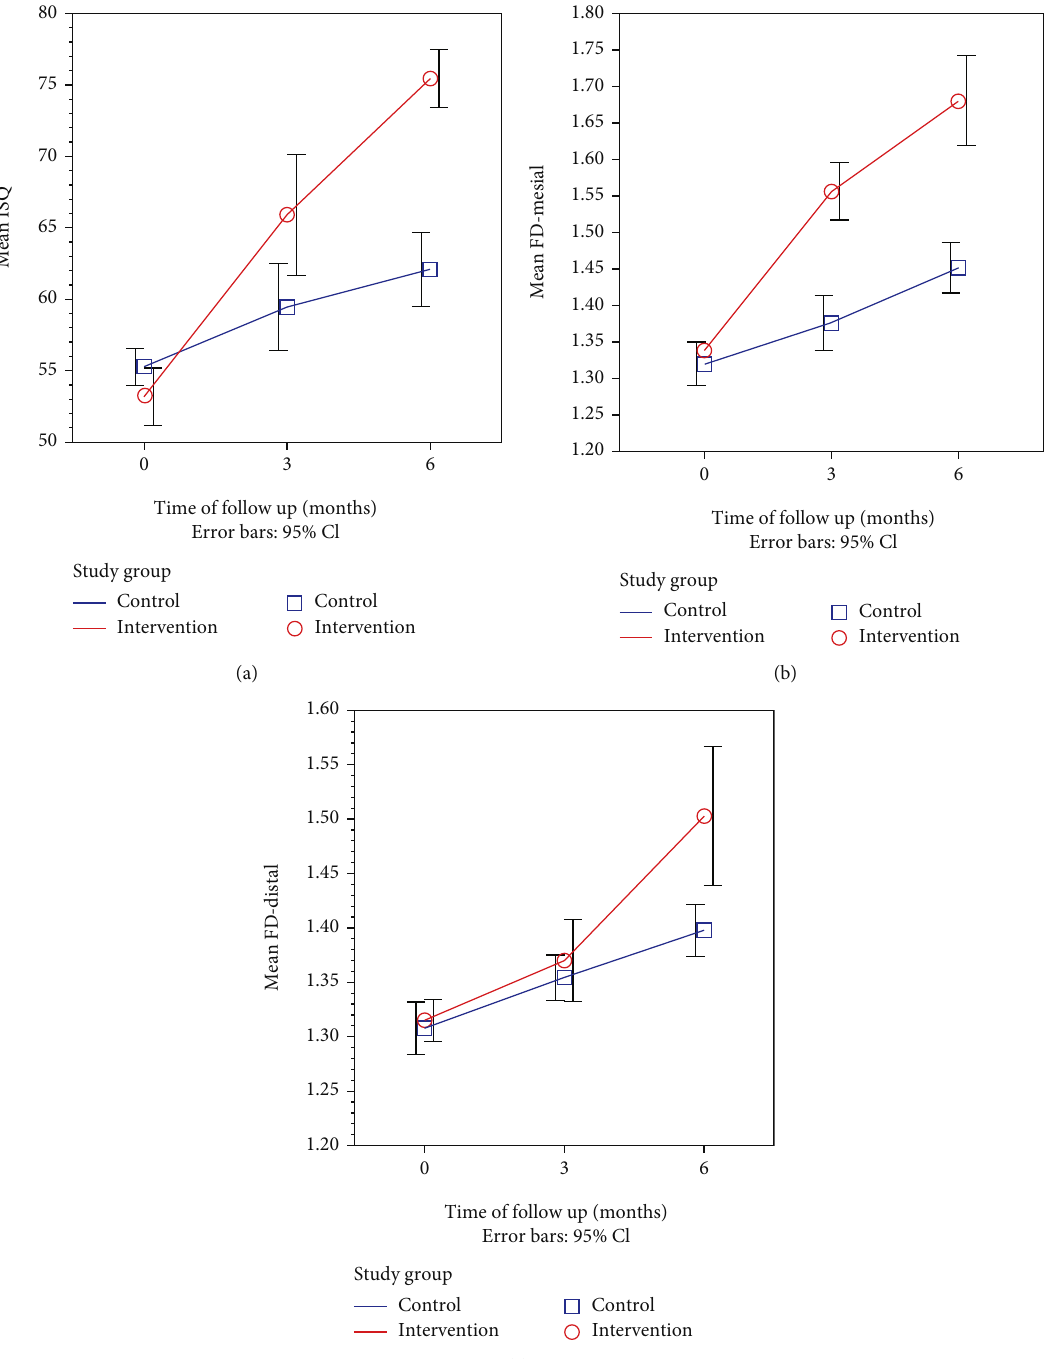
Figure 4: LIPUS stimulation could signi fi cantly improve implant stability assessed by both resonance frequency (RF) analysis and fractal dimension (FD) analysis. Line graphs showing the time trend for (a) mean RF values, (b) mesial side mean FD values, and (c) distal side mean FD values after surgery in the intervention group compared with the control group. Adapted from Abdulhameed et al.